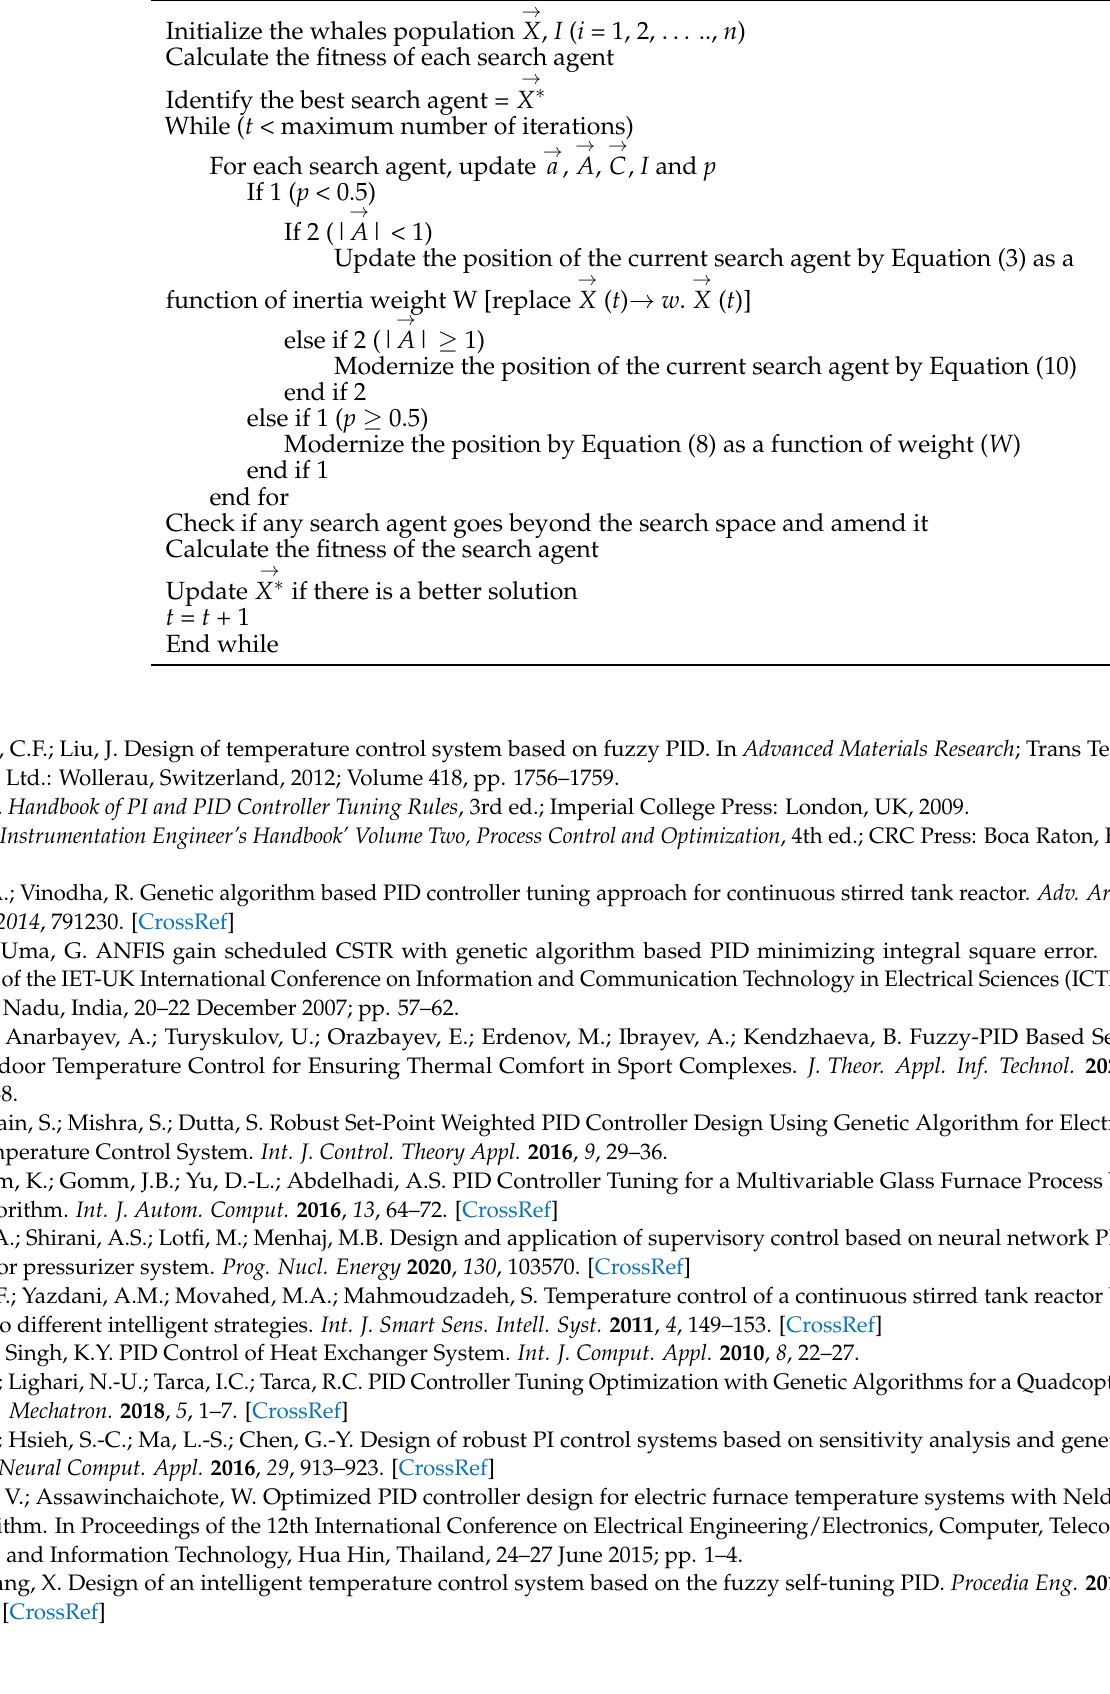
Algorithm A1: Enhanced Whale Optimization Algorithm